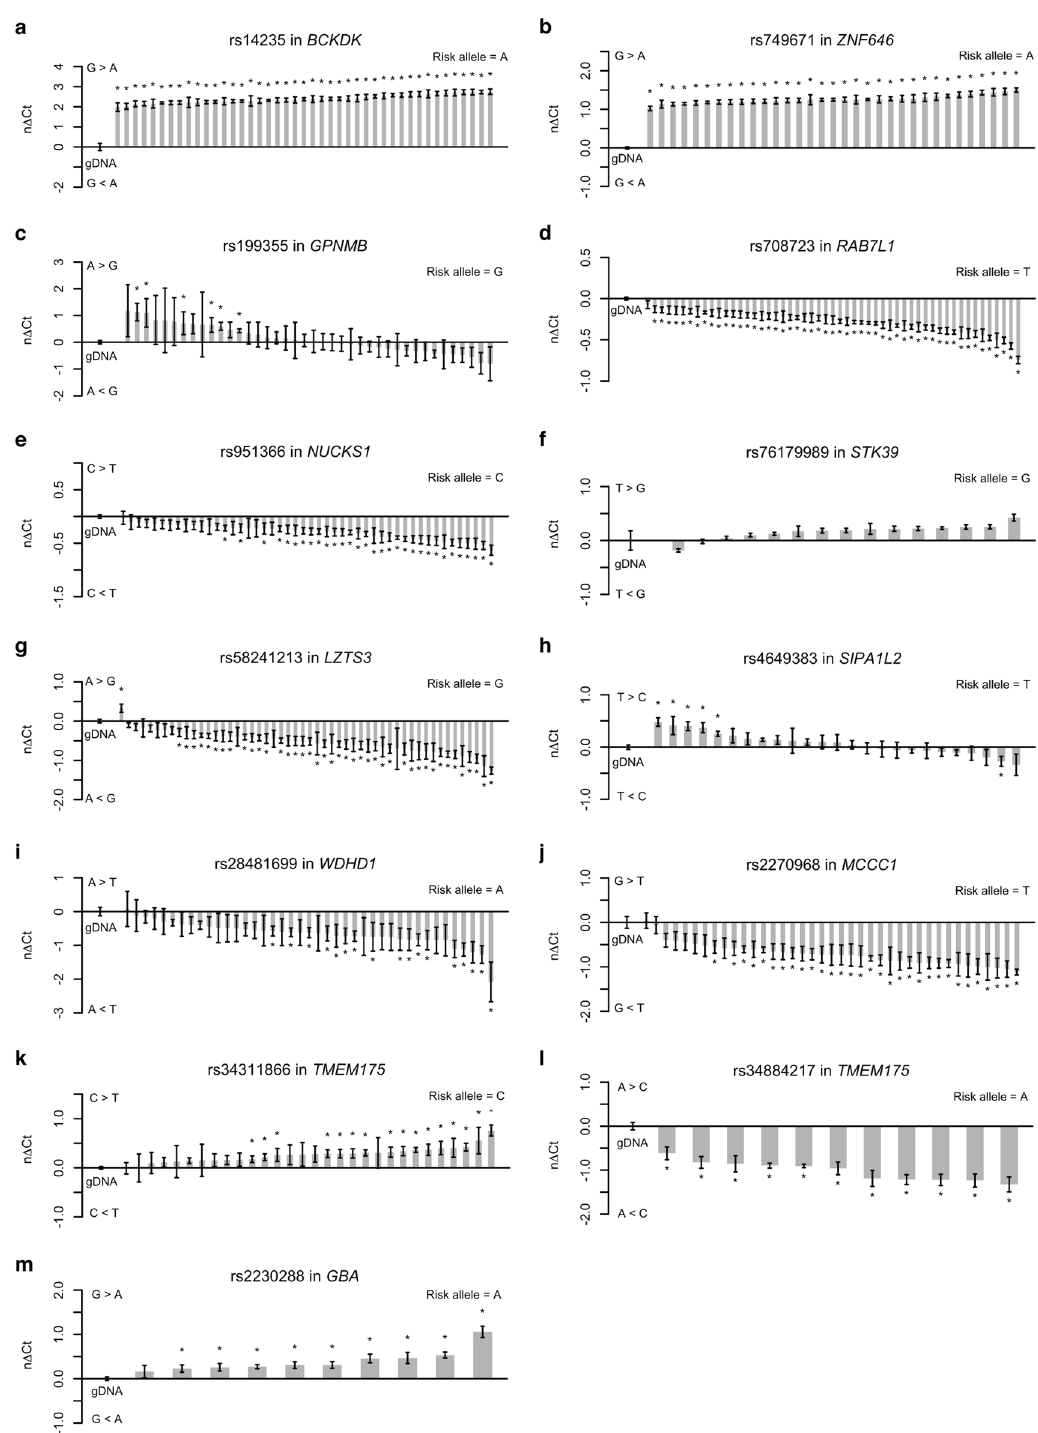
Figure 3. Allelic expression analyses of PD-associated risk loci in human brain samples. Allelic expression profiling was performed in heterozygous samples for ( a ) rs14235 in BCKDK , ( b ) rs749671 in ZNF646 , ( c ) rs199355 in GPNMB , ( d ) rs708723 in RAB7L1 , ( e ) rs951366 in NUCKS1 , ( f ) rs76179989 in STK39 , ( g ) rs58241213 in LZTS3 , ( h ) rs4649383 in SIPA1L2 , ( i ) rs28481699 in WDHD1 , ( j ) rs2270968 in MCCC1 , ( k ) rs34311866 in TMEM175 , ( l ) rs34884217 in TMEM175 , and ( m ) rs2230288 in GBA to determine the ratio of transcript levels for each allele. Data are presented as normalized change in Ct between the two alleles (nΔCt). Each column represents five replicate measurements and error bars show the standard error of the mean. Significant differences between each column and the genomic DNA (gDNA) control were identified using a Mann–Whitney U test. Significance was defined as P ≤ 0.05 symbolized with an asterisk. Ct cycle